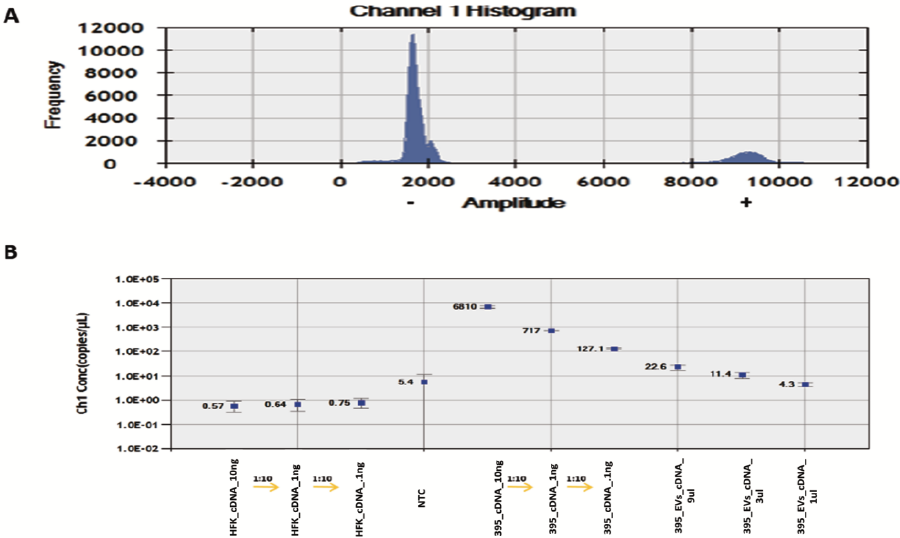
Figure 5. ddPCR detection of HPV E7 cDNA in serially diluted HFK, GUMC-395, and GUMC-395 EVs. ( A ) Histogram results for droplet separation based on HPV E7 assays. Positive droplets were observed at an amplitude of about 9000, whereas negative droplets were observed at an amplitude of about 1800. ( B ) The concentrations (copies/ µ L) of the HPV E7 as processed by QuantaSoft. The concentration and Poisson confidence intervals for each “merged” well were computed using the QuantaSoft Software. Concentrations (copies/ µ L) represent the measurement of HPV E7 cDNA in merged wells for each sample. Error bars indicate the Poisson 95% confidence intervals for each measurement. HFK = Human Foreskin Keratinocytes ( − HPV); GUMC-395(+HPV); NTC = No Template